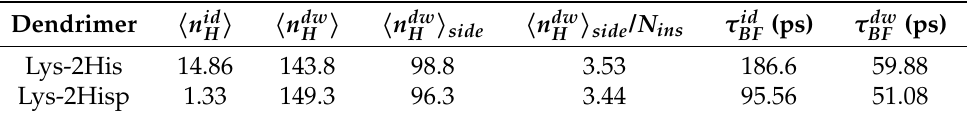
Table 4. The hydrogen bond characteristics of Lys-2His and Lys-2Hisp: the total average number of (cid:105) , the total average number of hydrogen bonds between the intra-dendrimer hydrogen bonds (cid:104) n id H (cid:105) , the average number of hydrogen bonds between the side groups of dendrimer and water (cid:104) n dw H (cid:105) spacers in the dendrimer and water (cid:104) n dw side and the average number of such hydrogen bonds per H id (cid:105) side group (cid:104) n dw and dendrimer–water τ dw hydrogen side / N ins . The life-time of intra-dendrimer τ H BF BF bonds at temperature T = 310